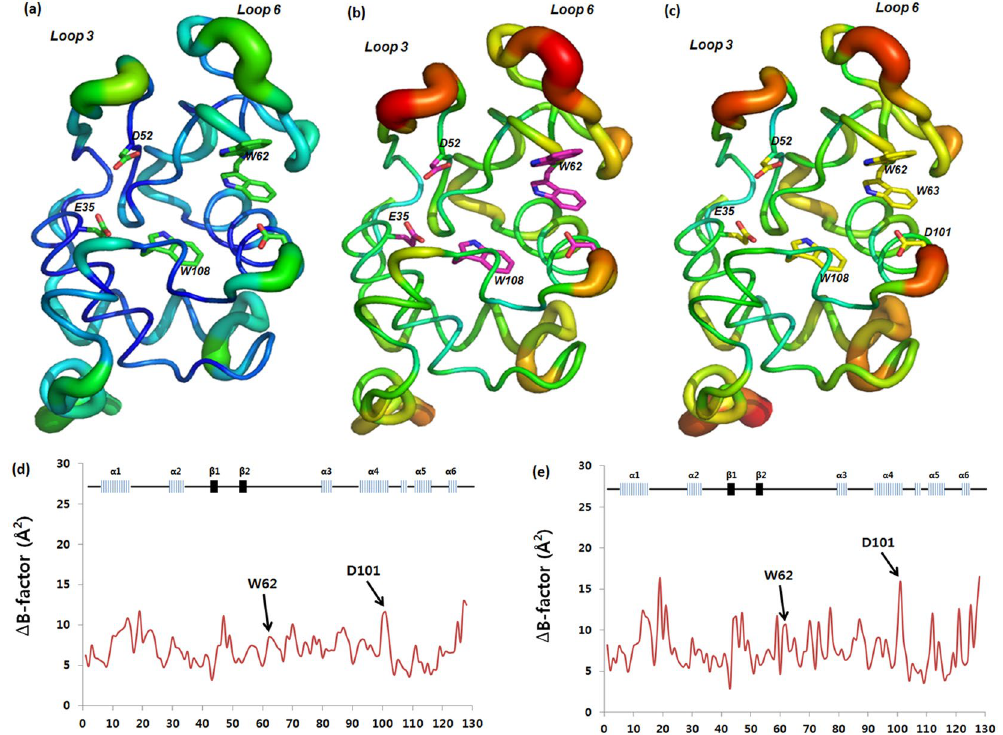
Figure 6. Thermodynamic change in enzyme structure after the 12 min plasma treatment analyzed by X-ray crystallography. ( a ) Control (without treatment); ( b ) Air-DBD; ( c ) N 2 -APPJ; Note that the wider and red indicates higher B-factors while narrower and blue means low B-factors. ( d ) Average B-factor differences in lysozyme residues after Air-DBD and ( e ) Average B-factor differences in lysozyme residues after N 2